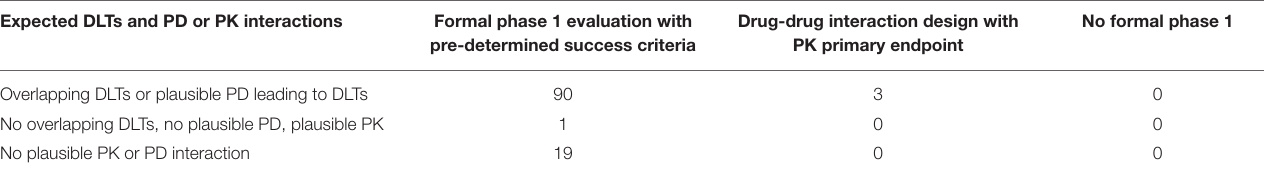
TABLE 2 | Expected dose-limiting toxicities (DLTs) and pharmacodynamic (PD) or pharmacokinetic (PK) interactions vs. the type of phase 1 study design in surveyed trials. Expected DLTs and PD or PK